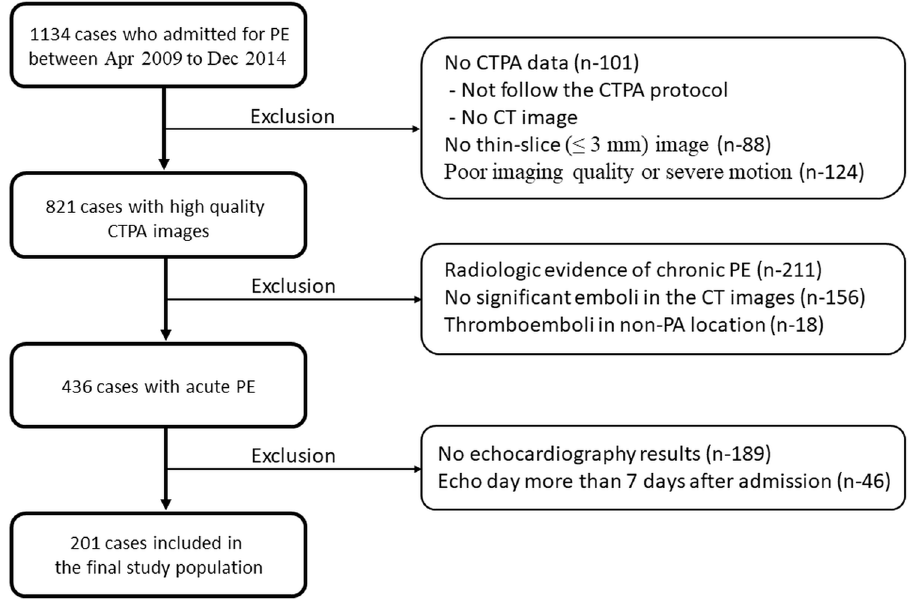
Figure 4. Flow chart of enrolled participants meet the